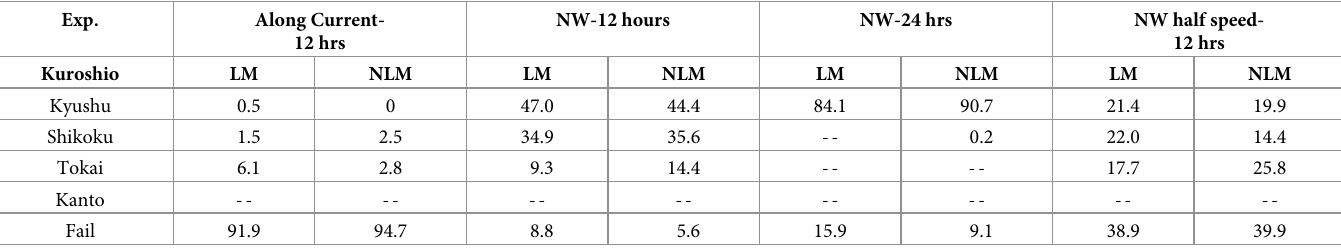
Table 2. Percentage of successful recruitment to various regions of southern Japan in the swimming sensitivity experiment during the 2 large meander (LM; 2005, 2018) and non-large meander (NLM; 2010, 2016) years. Fail accounted for those v-larvae that did not approach the Japanese shore.